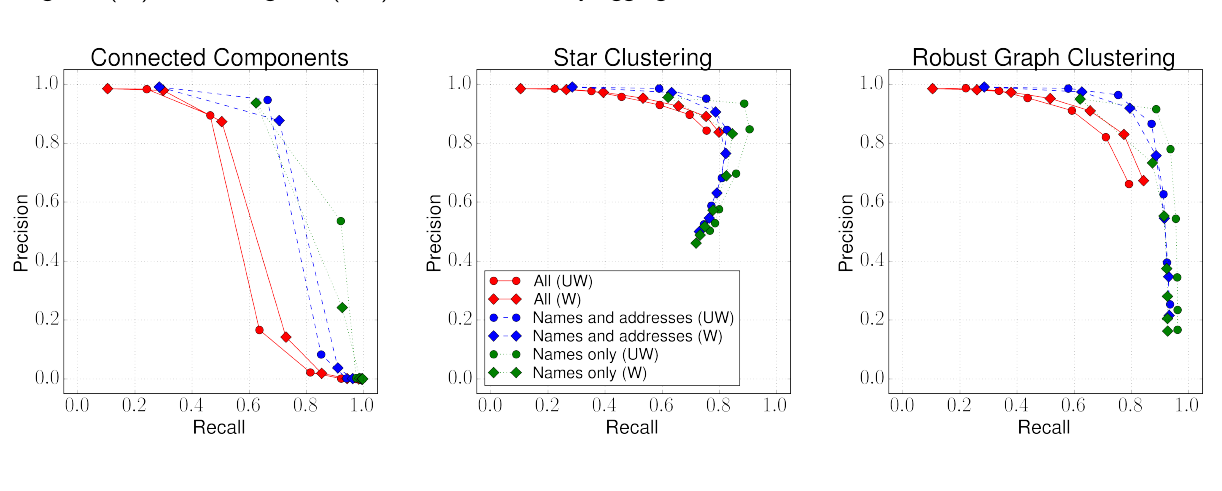
Figure 7: Precision-recall curves for three clustering techniques based on six different similarity graphs as described in Section 3 with weighted (W) and unweighted (UW) attribute similarity